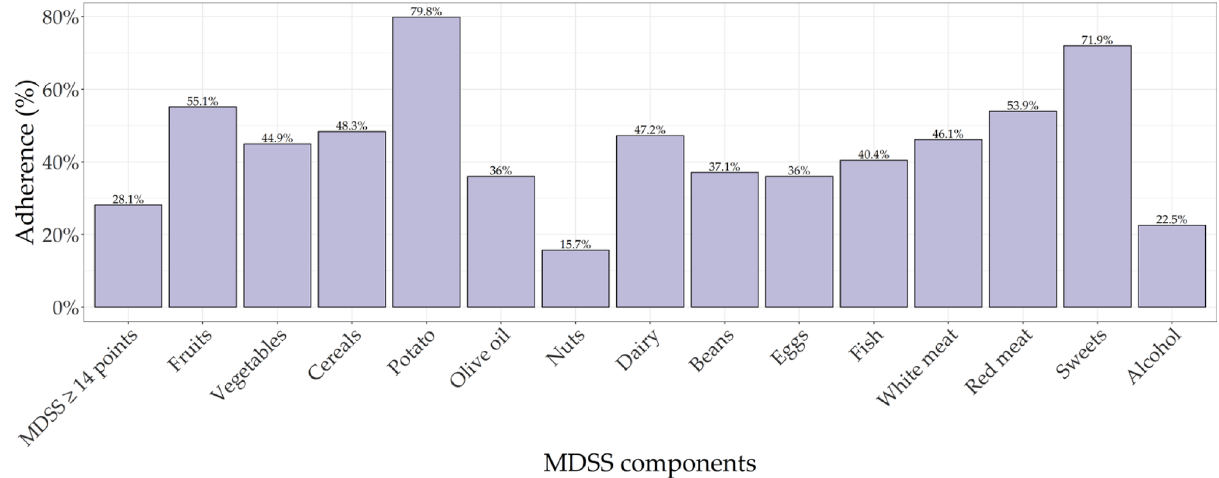
Figure 1. Mediterranean diet adherence in Dalmatian KTRs. MDSS Mediterranean Diet Serving